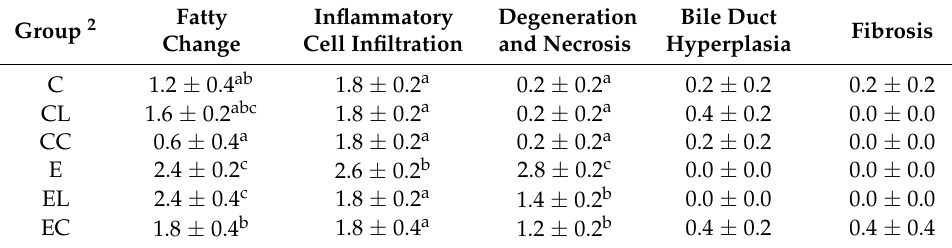
Table 5. Effects of different dietary fat sources on hepatic histopathological scores in rats 1 .